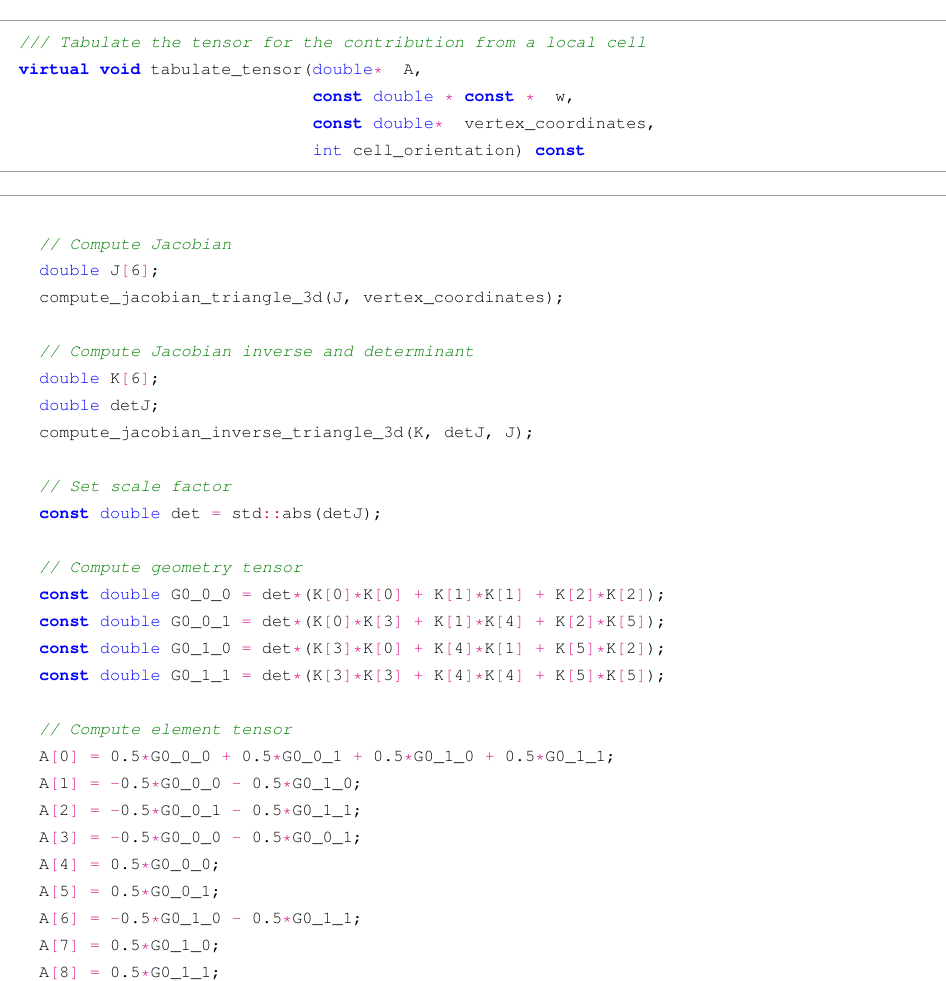
Fig. 6. Generated code for the bilinear form corresponding to the weak Laplacian. This code is extracted from snippets/laplacian.h in the Supplement, which was obtained by running FFC on the code in Fig. 4. The array A represents the 3 × 3 local element tensor for the discrete Laplacian. For a full explanation of FFC and the code it generates, the reader is directed to Logg et al.